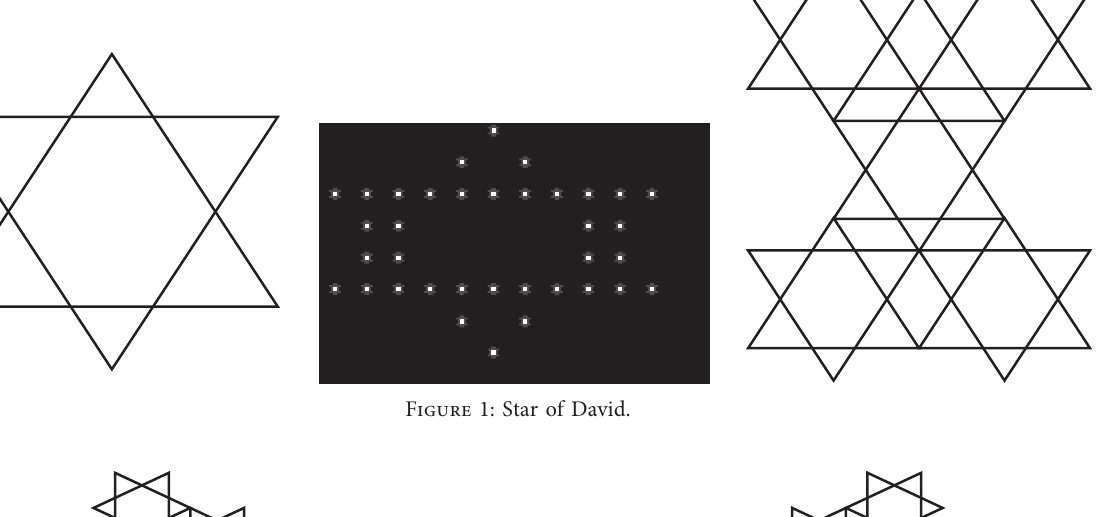
Figure 1: Star of David.